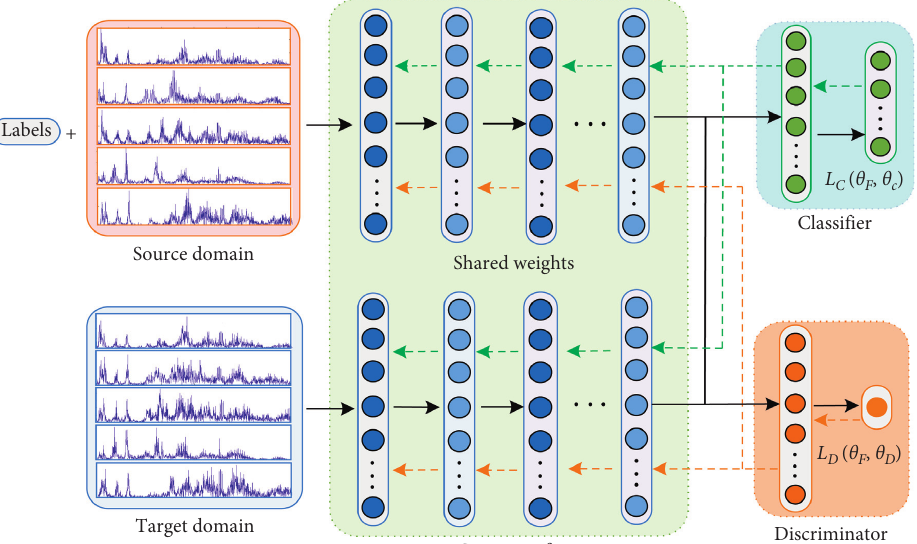
Figure 1: The structure of DAAN.